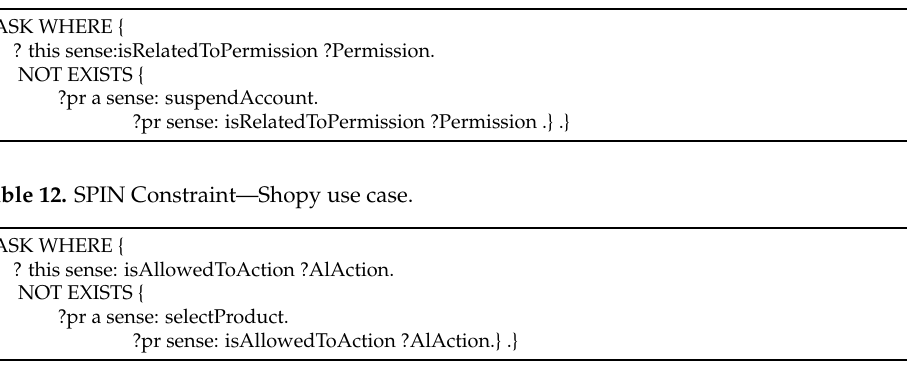
Table 11. SPIN Constraint—ATM use case.